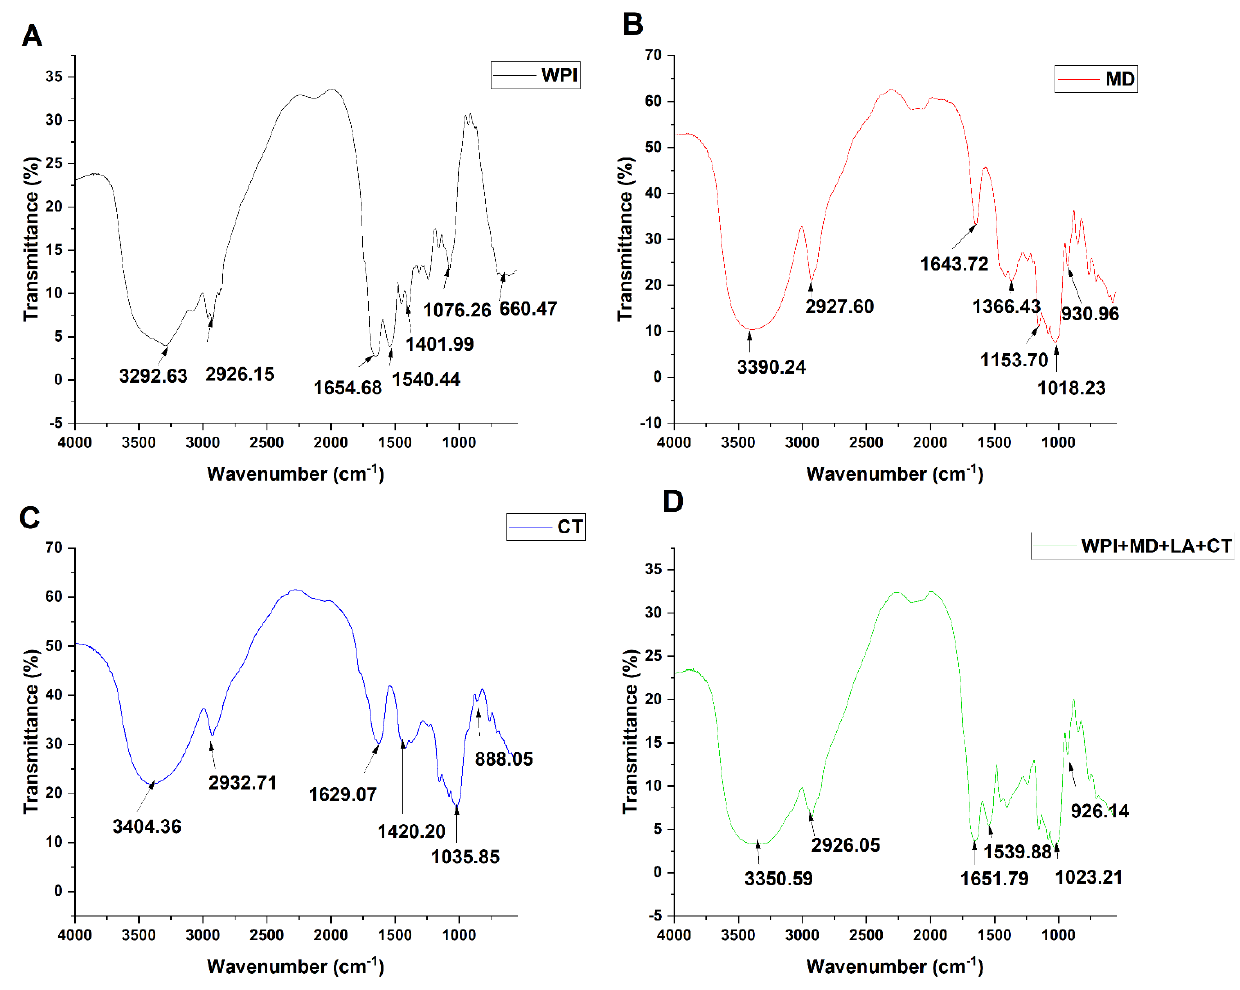
Figure 2. FTIR spectra of WPI ( A ), MD ( B ), CT ( C ), and WPI + MD + LA + CT ( D ).